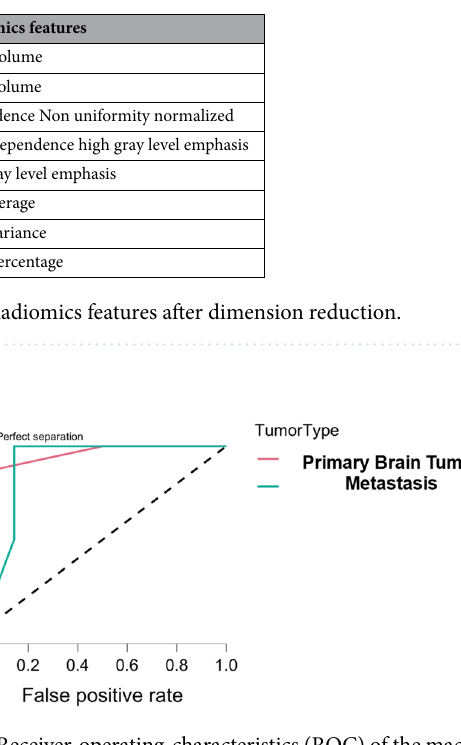
Figure 2. Receiver-operating-characteristics (ROC) of the machine learning algorithm to correctly identify primary brain tumors and metastases. The overall area-under-the-curve (AUC) was